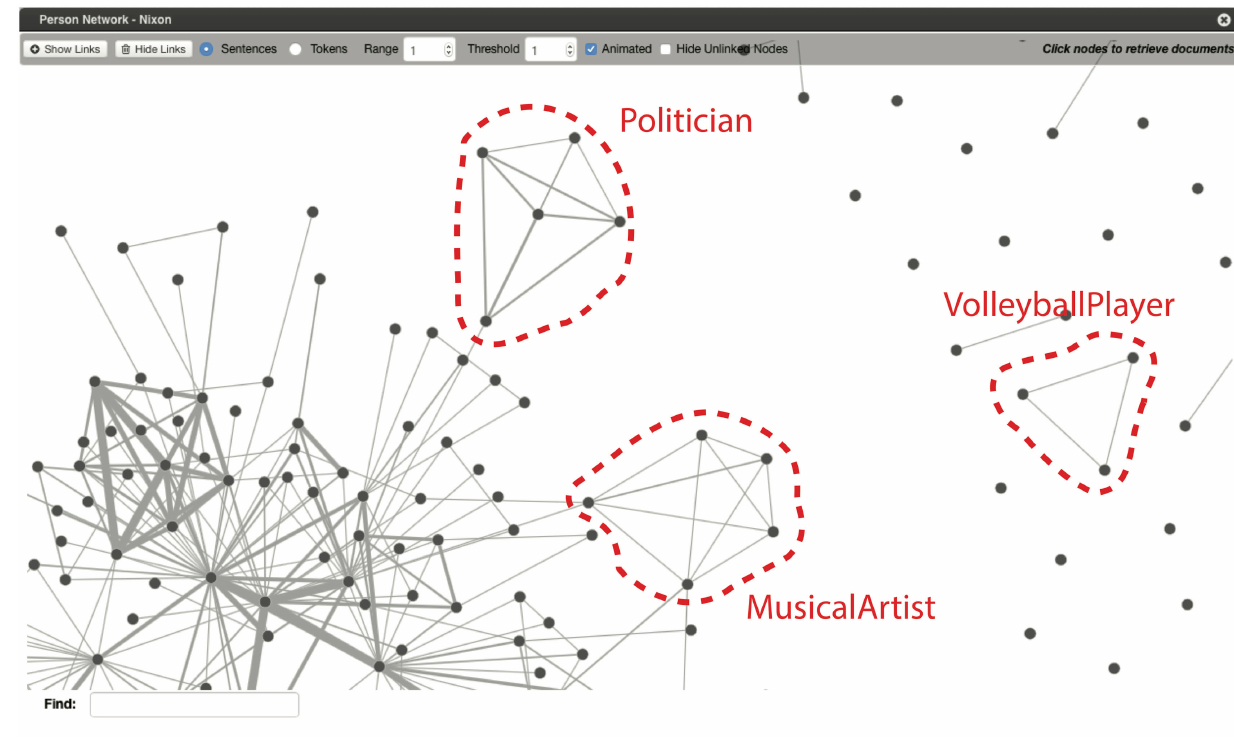
FigUre 1 | Visualization of a large persons’ network with examples of labeled